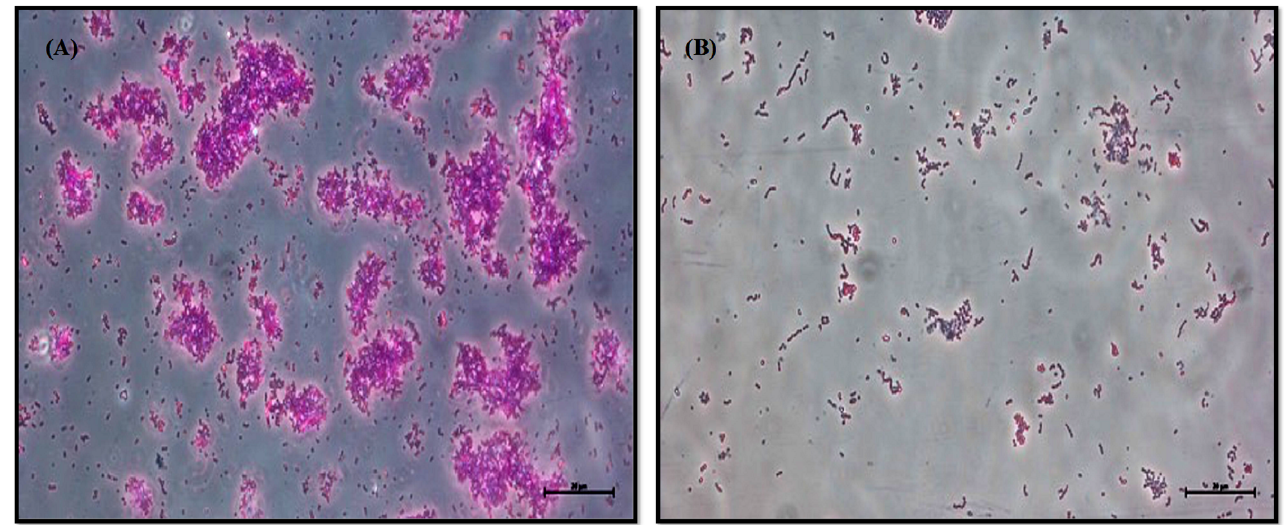
Figure 2. Light micrograph of biofilm formed by S. pyogenes . The figure displays, ( A ) the control S. pyogenes forming a well—structured biofilm stained with crystal violet. ( B ) LME (4.88 µg/mL) im- pedes microcolony and biofilm formation in S. pyogenes